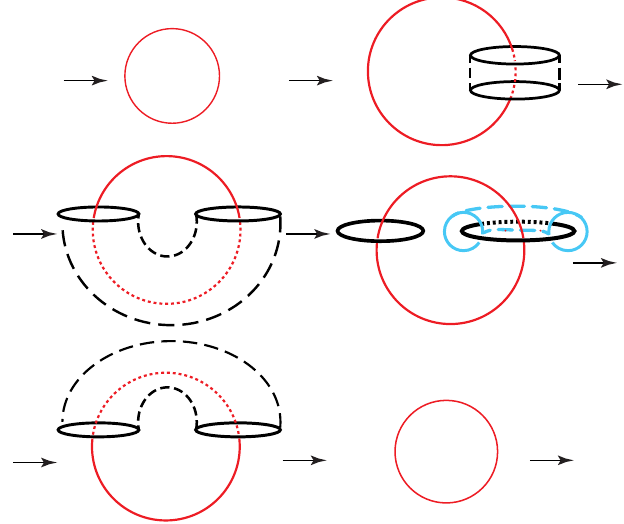
FIG. 3. Time sequence for three-flux-loop braiding. This process has nontrivial triple linking number of three worldsheets. First, loop G (red) is created and grows, forming the G worldsheet. Then, loop H (black) emerges, encircling loop G halfway. Then, loop F (blue) completely encircles loop H . After this, loop H finishes the route around loop G . Finally, loop G is